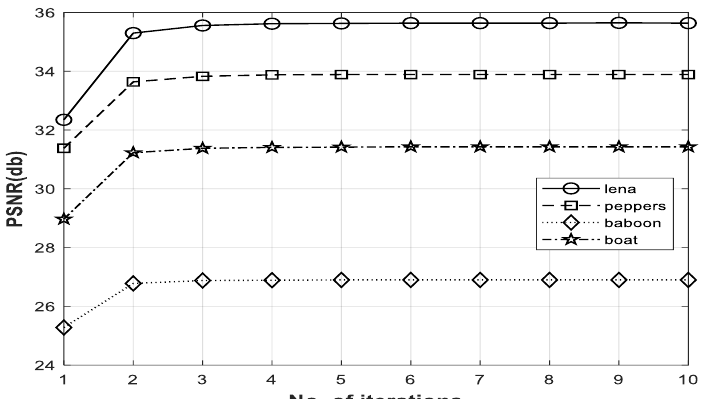
Table 1. Detection results comparison of different methods for Lena image when corrupted with 30% to 60%